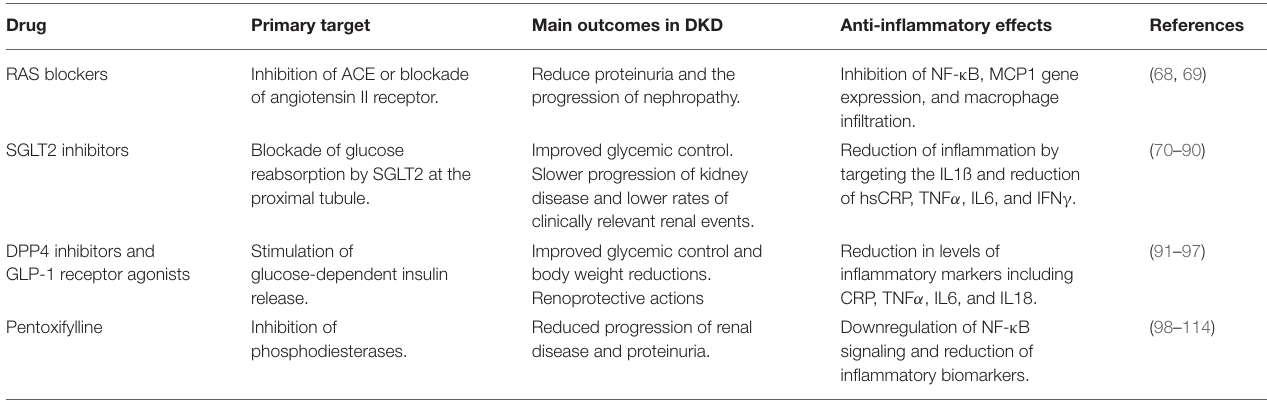
TABLE 1 | Therapeutic strategies in the DKD with potential anti-inflammatory properties. Drug Primary target Main outcomes in DKD Anti-inflammatory